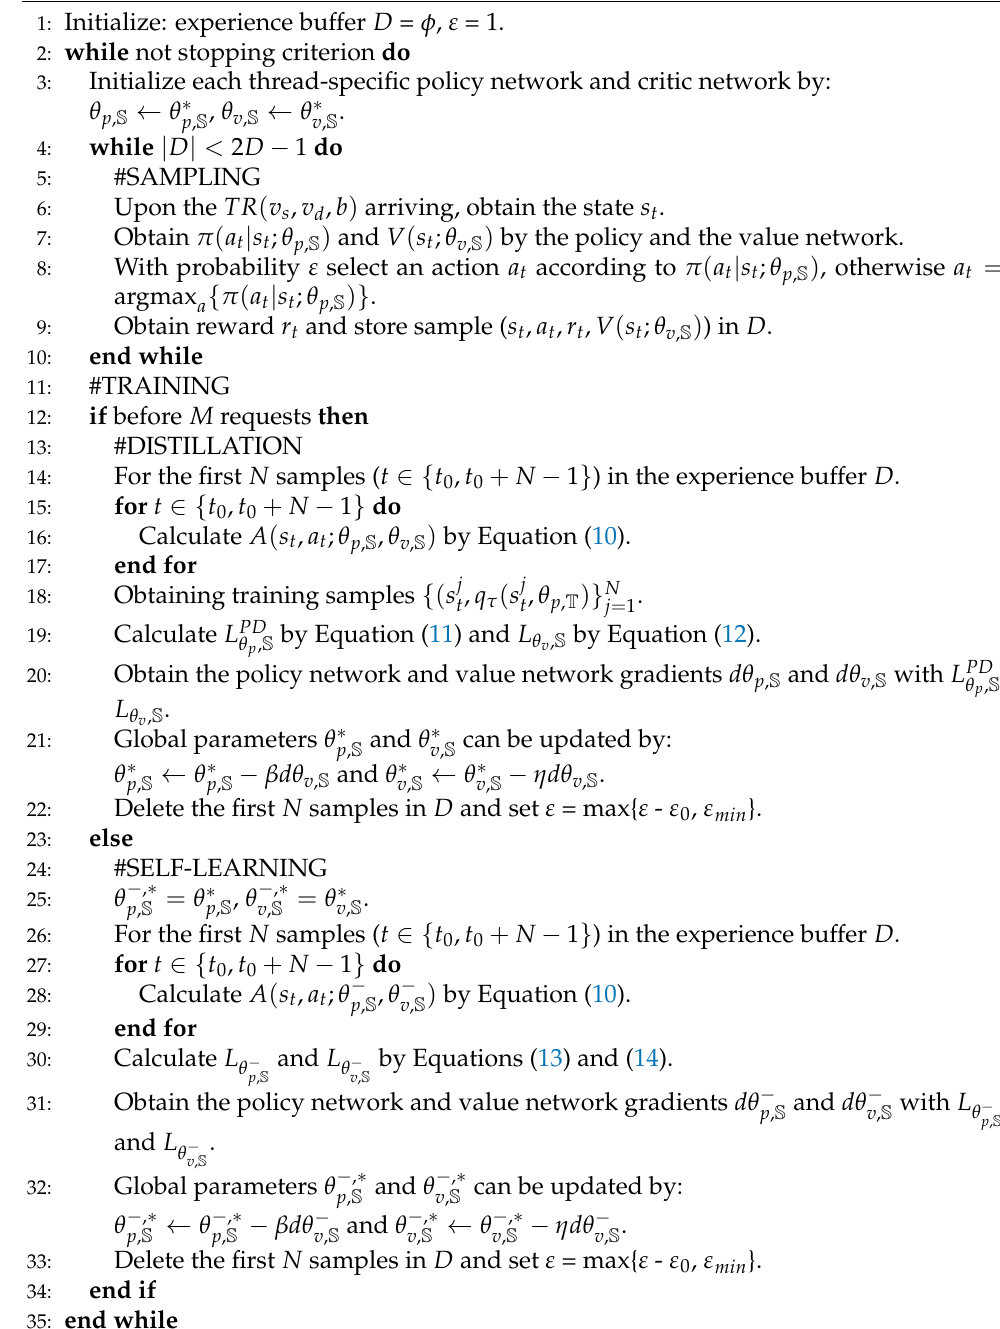
Algorithm 2 Training algorithm of student